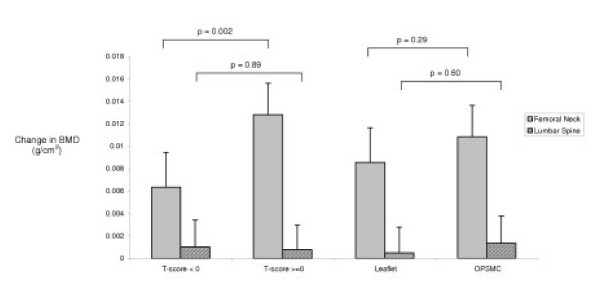
Change in BMD by T-score group and educational intervention over 2 years. P-values are comparisons between T-score and between educational groups. Data is presented as mean and upper 95th CI.